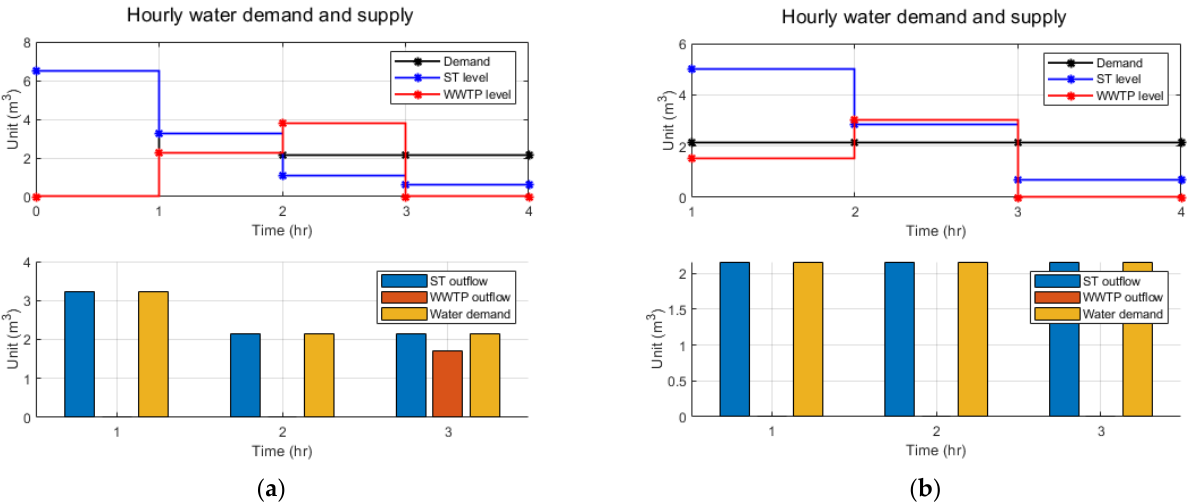
Figure 5. ( a ) Hourly water volume in the ST and WWTP during scenarios 1 and 3. During time-steps 1 and 2, the total water demand is being supplied by the outflow of the ST. There is no outflow from the WWTP for the first 2 h of operation, but there is an increase in its volume as the customers use water during these time-steps. During time-step 3, the WWTP starts supplying water to the ST, which in turn, supplies water to meet the demand, ( b ) Hourly water volume in the ST and WWTP during scenario 2. Since the ST tank has enough water to supply the low water demand for scenario 2 the WWTP does not need to be run for this scenario, as shown by zero outflow in Figure 5b. The wastewater that was stored in time-steps 1 and 2 will flow out of the WWTP as effluent, as indicated by the reduced water volume in the WWTP at time-step 3.